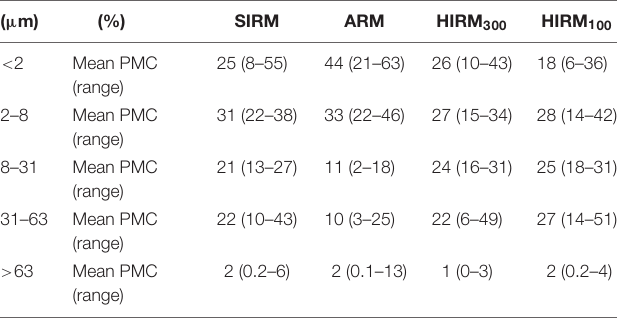
TABLE 1 | Percentage Magnetic Contribution (PMC) of each particle size fraction to bulk magnetic concentration